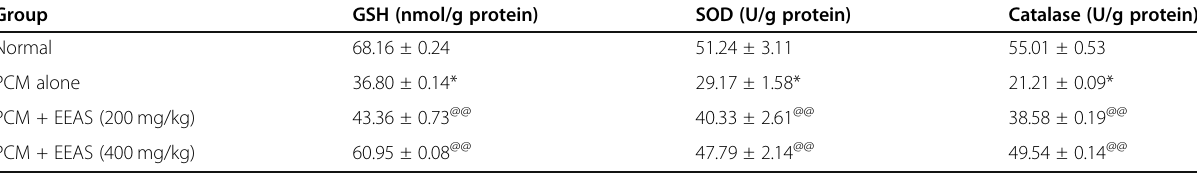
Table 2 Effect of EEAS on GSH, SOD, and catalase on PCM-induced nephrotoxicity in rats Group